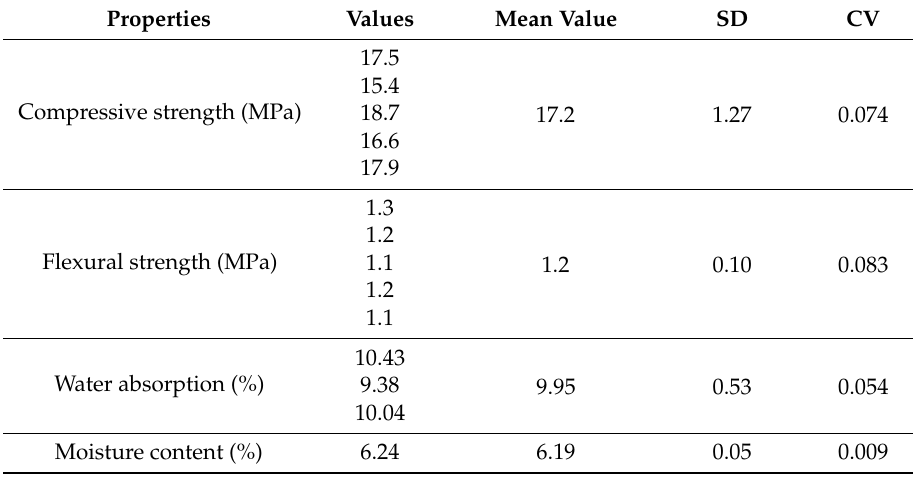
Table 4. Mechanical and physical properties of AASCHBs cast from Mix